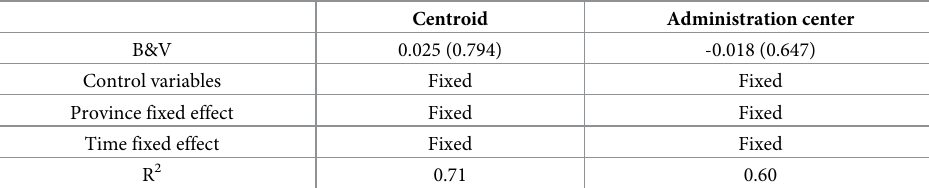
Table 7. Placebo test results.